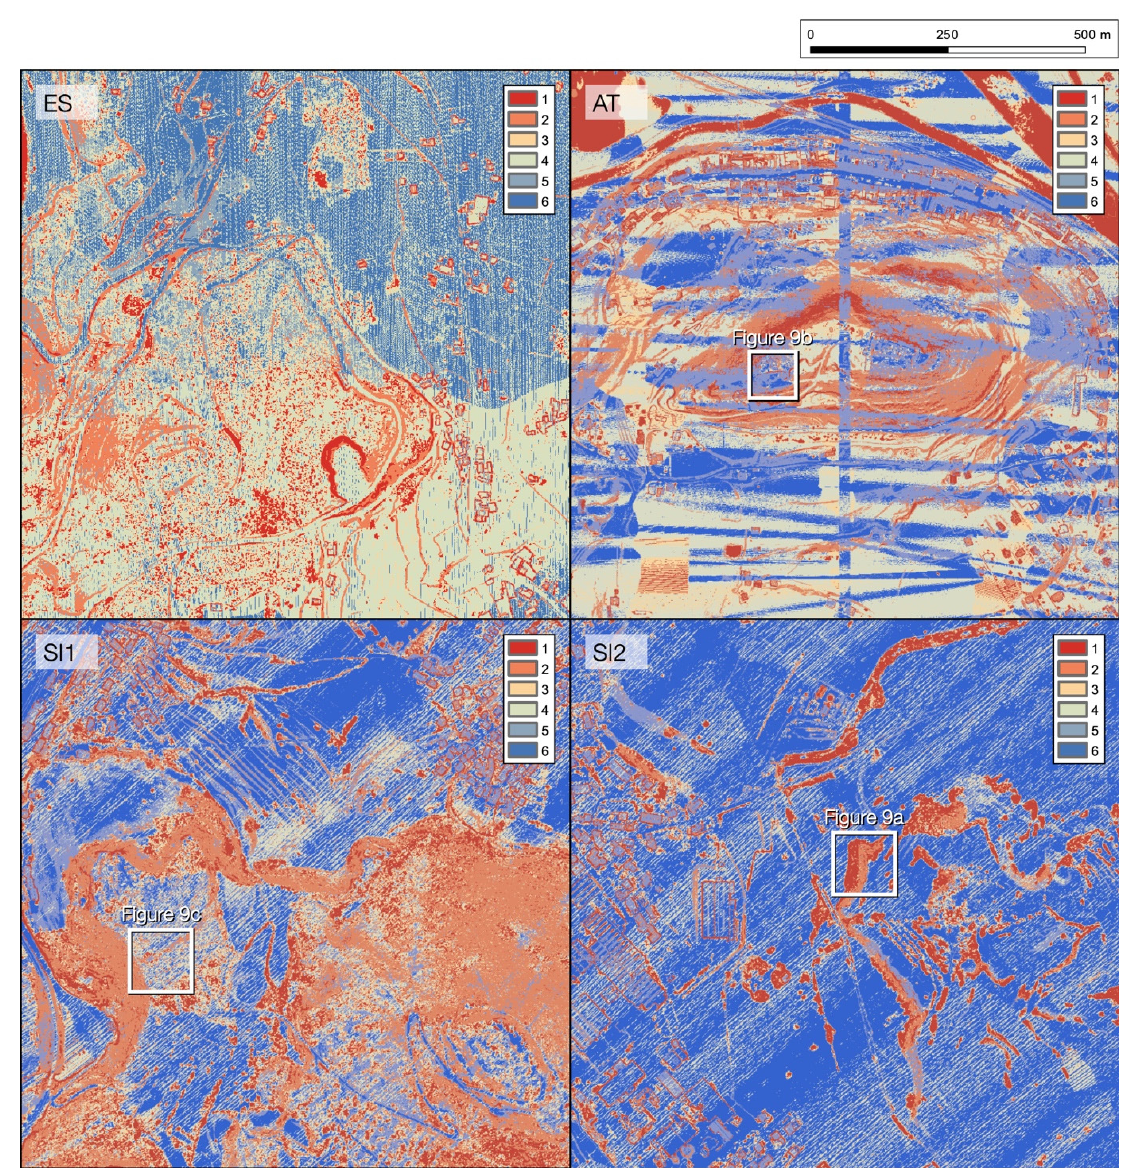
Figure 8. DFM confidence maps for each test site (higher is better).